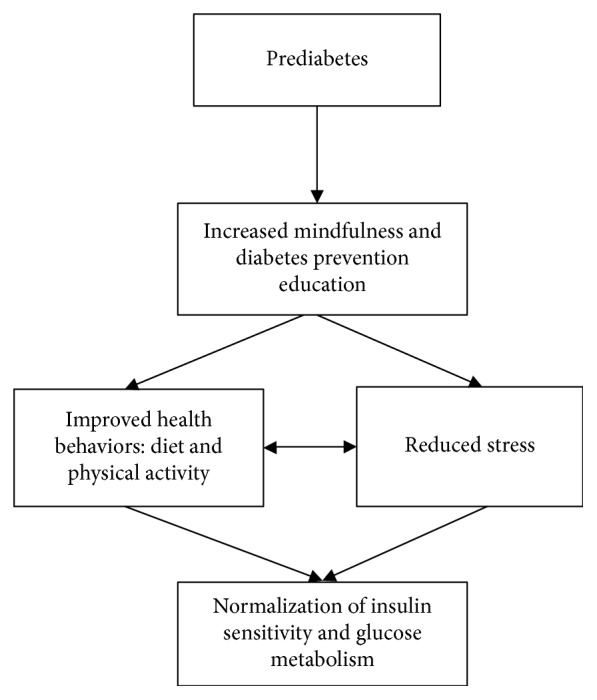
Conceptual model.